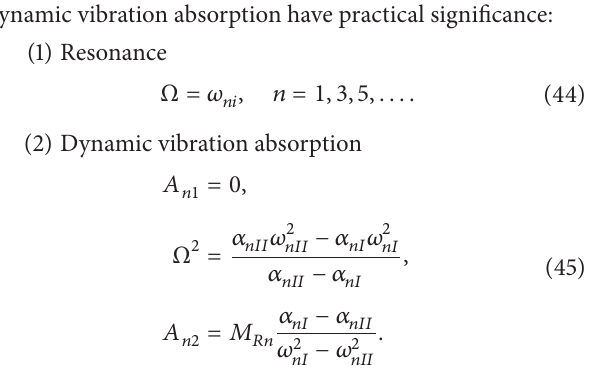
Figure 3: Double single-walled carbon nanotube system subjected to harmonic uniform distributed continuous